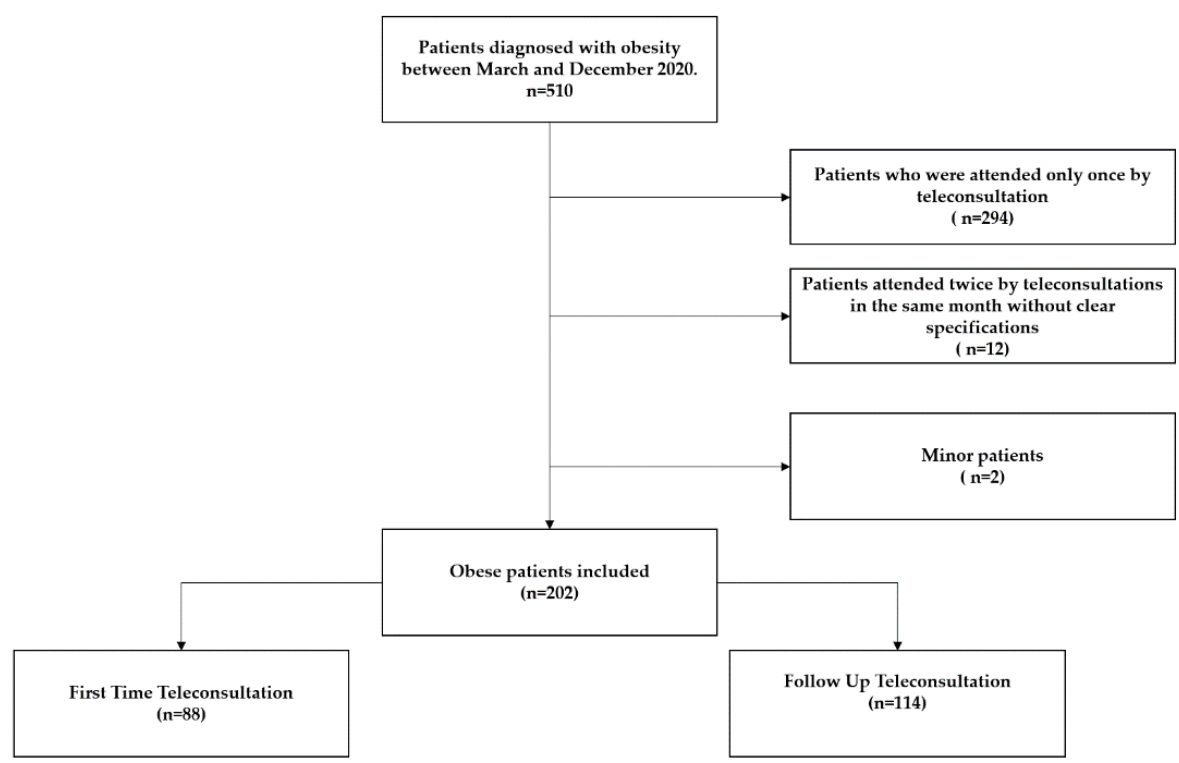
Figure 1. Included Patients Flow-Chart.